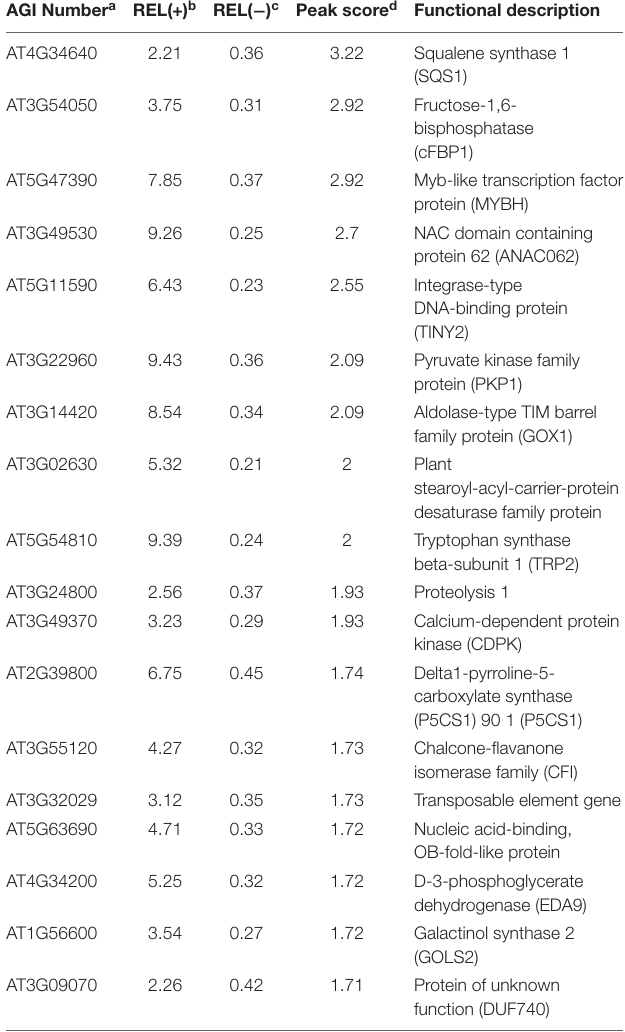
TABLE 1 | Candidate targeted genes of EsNAC1 in Arabidopsis